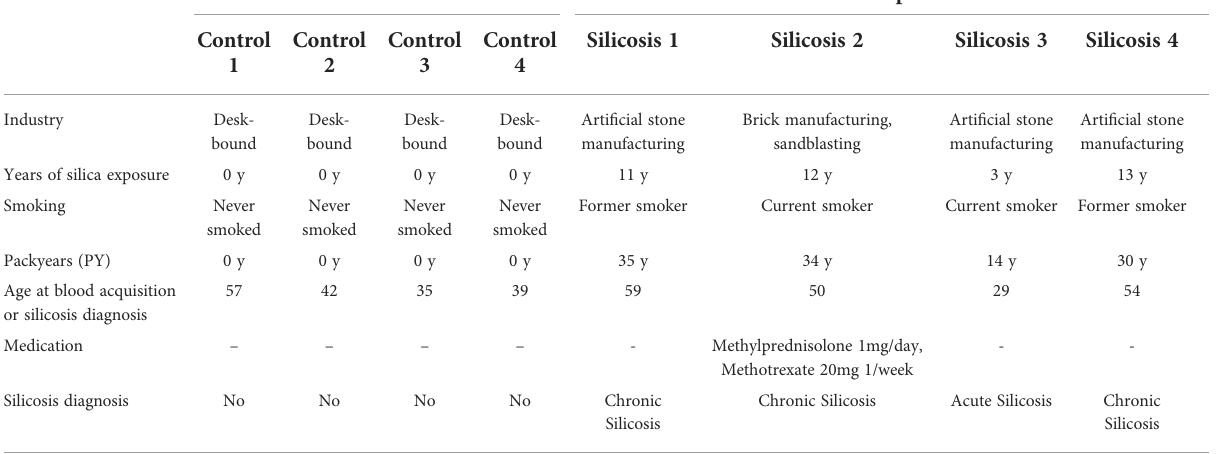
TABLE 2 Subject characteristics of study population upon